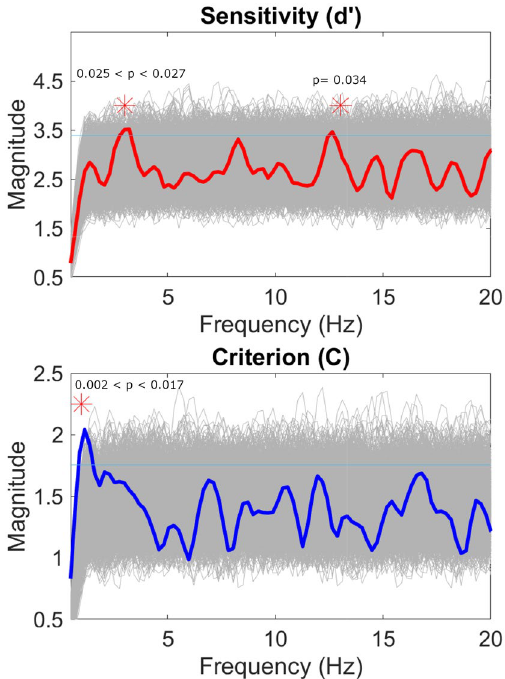
Figure 4. Power spectrum analysis for d’ (upper panel) and criterion (lower panel). The horizontal line shows the significance threshold, frequencies that cross the line are statistically different from chance.